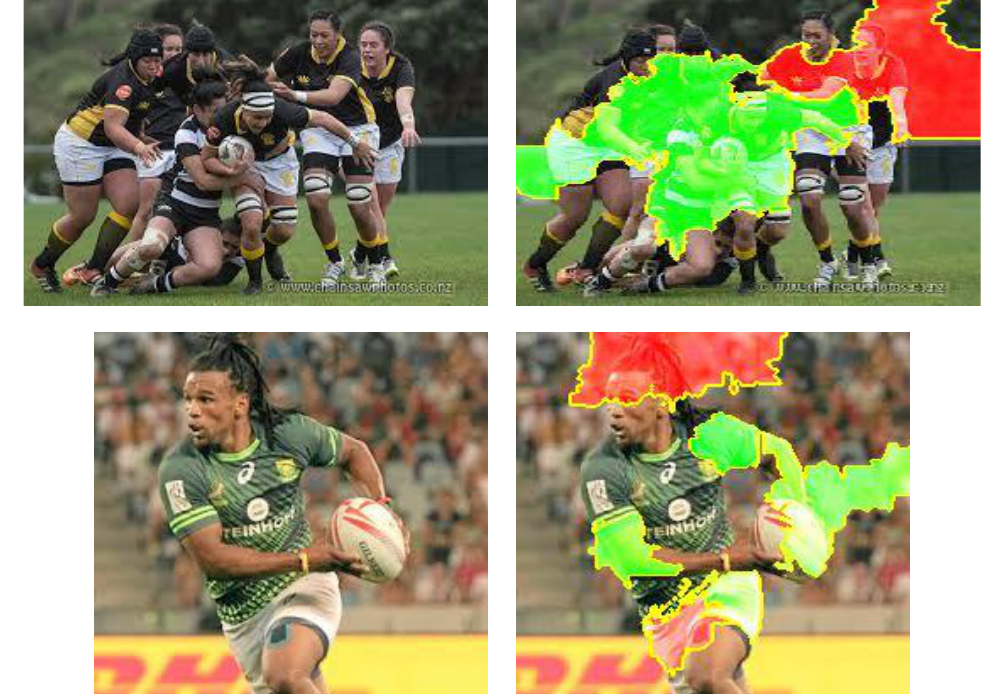
Figure 9. Examples of how LIME explained classifying images as rugby. Here, the packed formation of athletes and the rugby ball are decisive for classification; again, general features of athletes do not contribute to